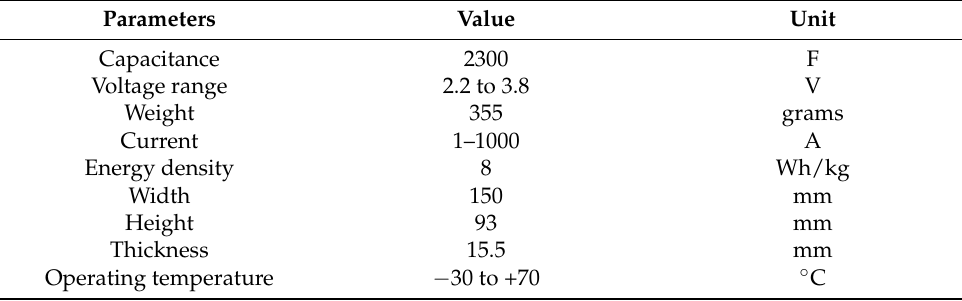
Table 1. Thermo-physical properties of the LiC